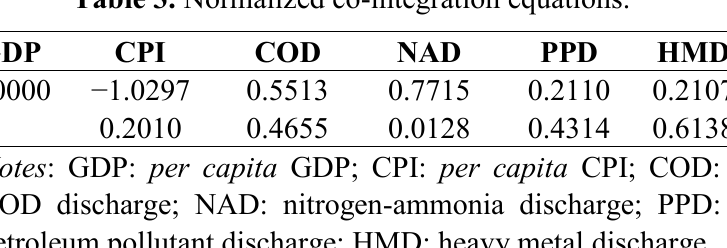
Table 3. Normalized co-integration equations.